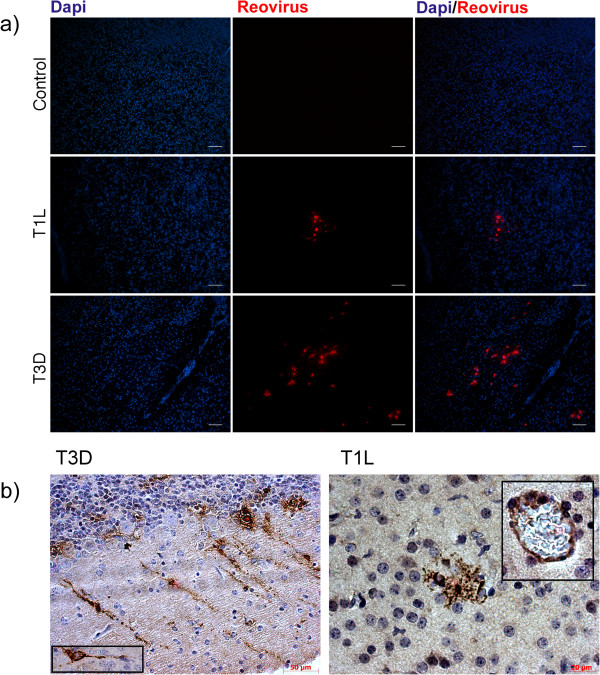
Immunofluoresent staining of virus infected suckling mouse brain sections. a) Two day old suckling mice were infected intranasaly with 105 pfu of either T1L or T3D before fluorescent antibody staining of frozen coronal brain sections at 7 days pi. T1L and T3D antigens were stained with virus specific antiserum as described in Figure 5. Cell nuclei were stained with DAPI, shown in blue. Size bars are 100 μM. b) Horse Radish Peroxidase staining (in brown) of formalin fixed paraffin embedded brains of T1L and T3D infected suckling mouse brains at 7 days pi. Staining of T3D infected brains showed the presence of neurons and neuronal processes whereas the cell type infected by T1L were non-neuronal and thus lacked processes. Staining of endothelial cells in blood vessels was also observed for both T3D (not shown ) as well as T1L infected brain that is shown in insert. Images were collected with the 20X objective lens and size bars are indicated.